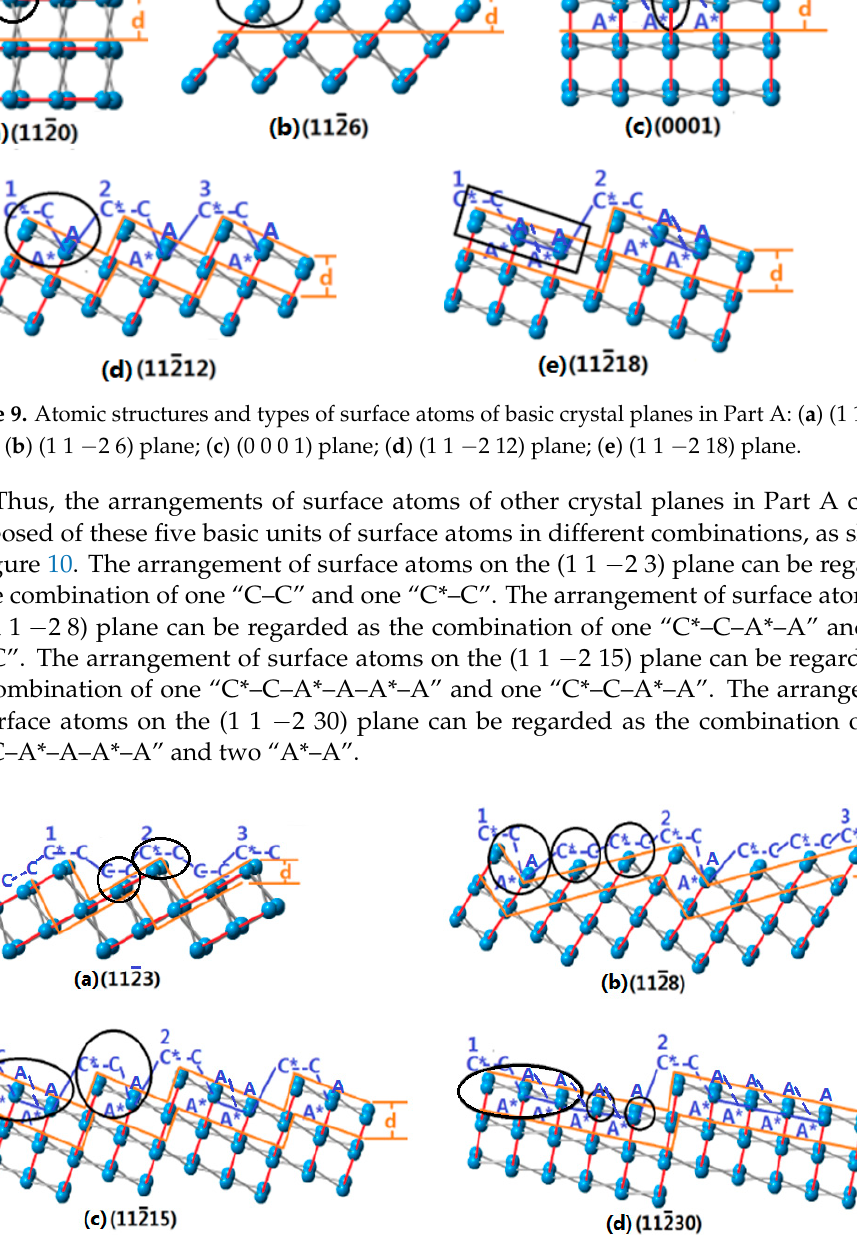
Figure 8. Atomic structures and types of surface atoms of representative crystal planes in Part A.